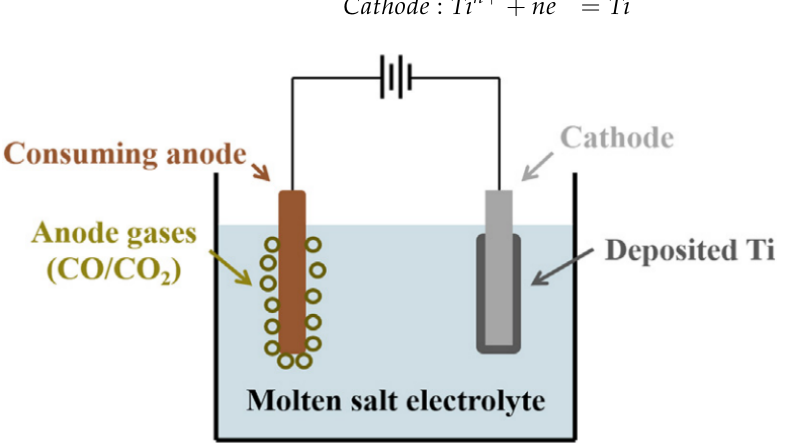
Figure 12. Schematic illustration of the USTB process [132] (Adapted from [132], with permission from Elsevier, 2020).